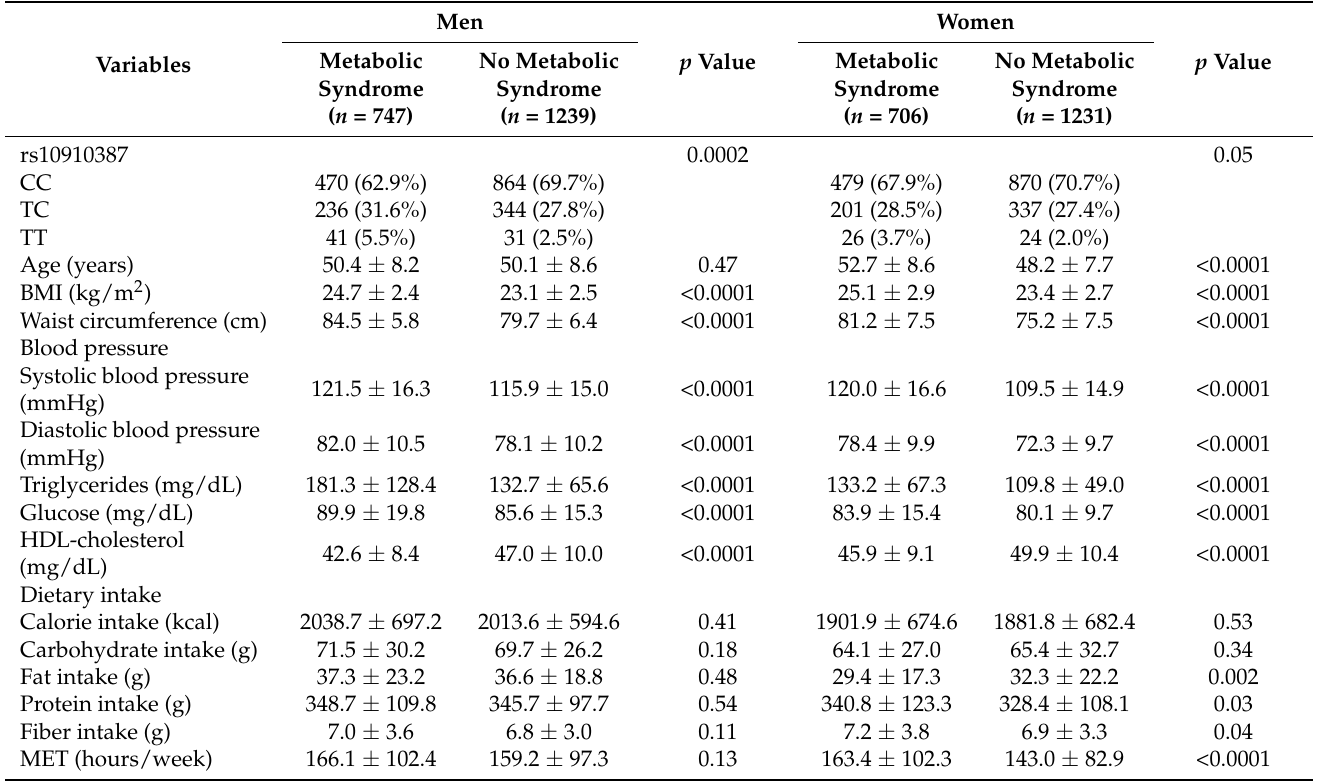
Table 1. General characteristics of the study participants based on the presence of metabolic